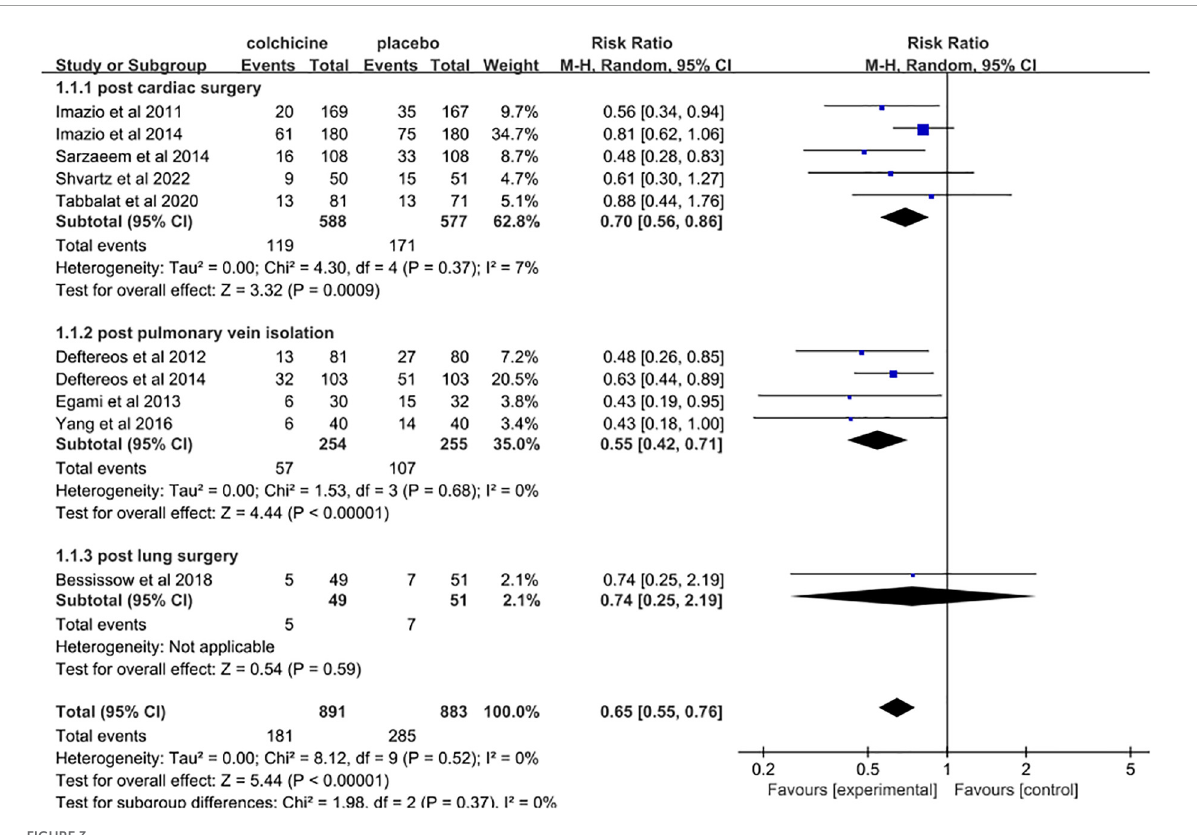
FIGURE3 Forest plot indicates risk ratios of post-operative atrial fibrillation with colchicine after the two trials were excluded.